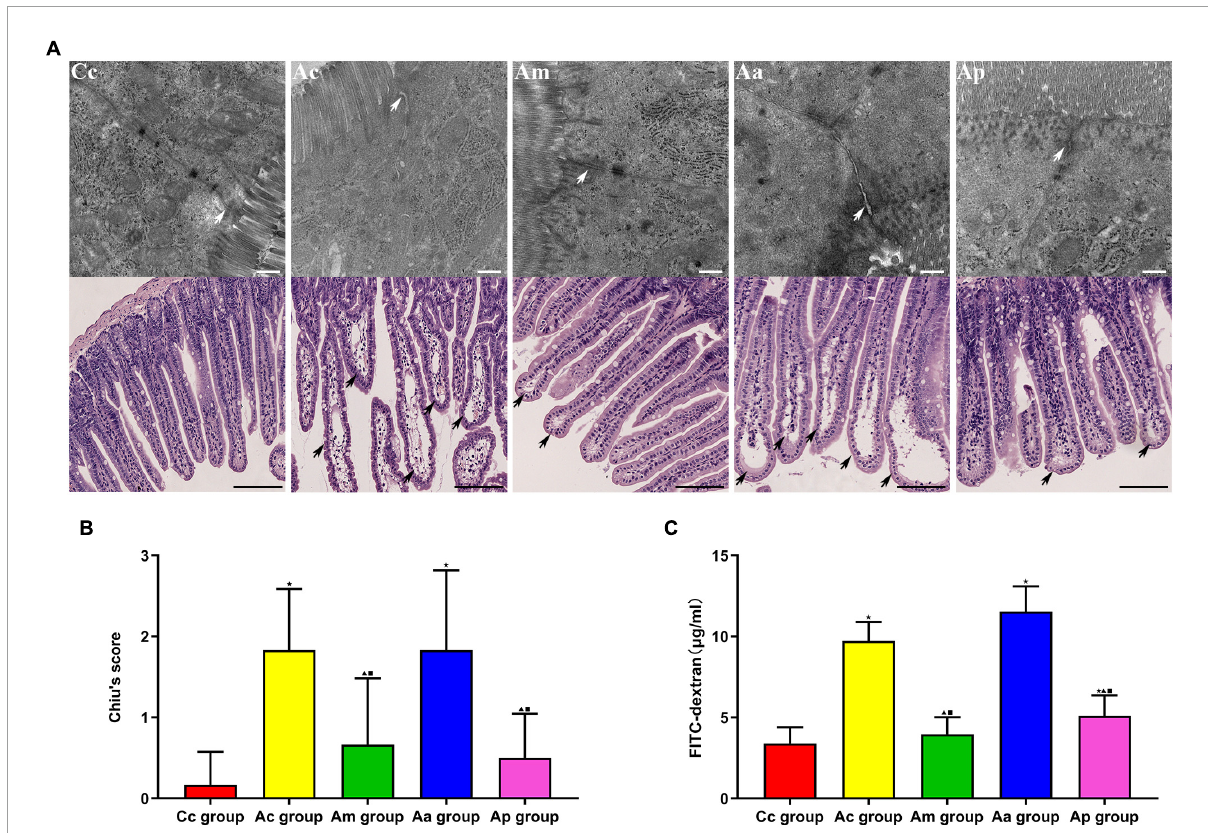
FIGURE3 Evaluations of the intestinal barrier integrity and function in each group ( n = 6, mean ± SD). (A) Representative images of hematoxylin and eosin (HE) staining (scale bar = 100 µ m) and Transmission electron microscopy (TEM) (scale bar = 500 µ m) in each group. White arrows show the tight junctions (TJs) between intestinal epithelial cells, and black arrows show intestinal mucous injury sites. (B) Comparison between Chiu’s score of all groups. (C) Comparison between the FITC-dextran level of all groups. A one-way analysis of variance (ANOVA), followed by the LSD multiple-range test, was used with an exception when comparing Chiu’s score, which was analyzed by the Kruskal–Wallis test. LSD-t and chi-square are presented in Supplementary Tables 2, 4 . (cid:70) P < 0.01 or P < 0.05 compared with the C57BL/6 control (Cc) group, (cid:78) P < 0.01 or P < 0.05 compared with the APP/PS1 control (Ac) group, (cid:4) P < 0.01 or P < 0.05 compared with the APP/PS1 antibiotic + manual acupuncture (Aa)